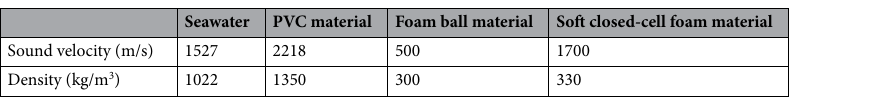
Table 2. The material properties of the seawater, PVC material, foam ball material, and soft closed-cell foam material used in the